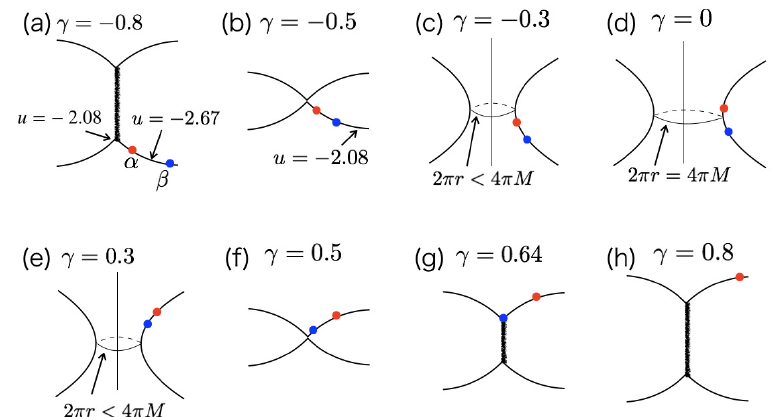
Figure 4. The dynamics of the throat and the motion of photons. A throat emerges instantaneously and connects two asymptotically flat space-sheets. After that, it expands and then starts to contract. Finally, it pinches off the connection between the two space-sheets.